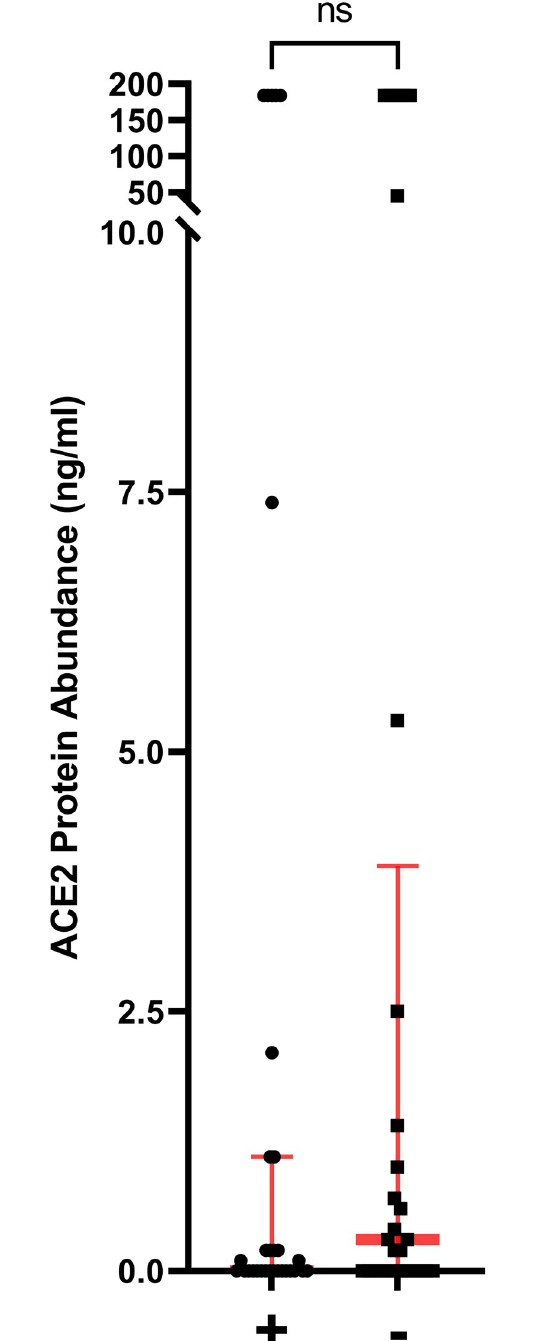
Fig 3. Abundance of soluble ACE2 protein in plasma of patients that had ACE2 antibodies in plasma compared to those that did not. There was no statistically significant difference in ACE2 protein between groups. The group labeled + had ACE2 antibodies and the group labeled–did not have ACE2 antibodies. (ns =